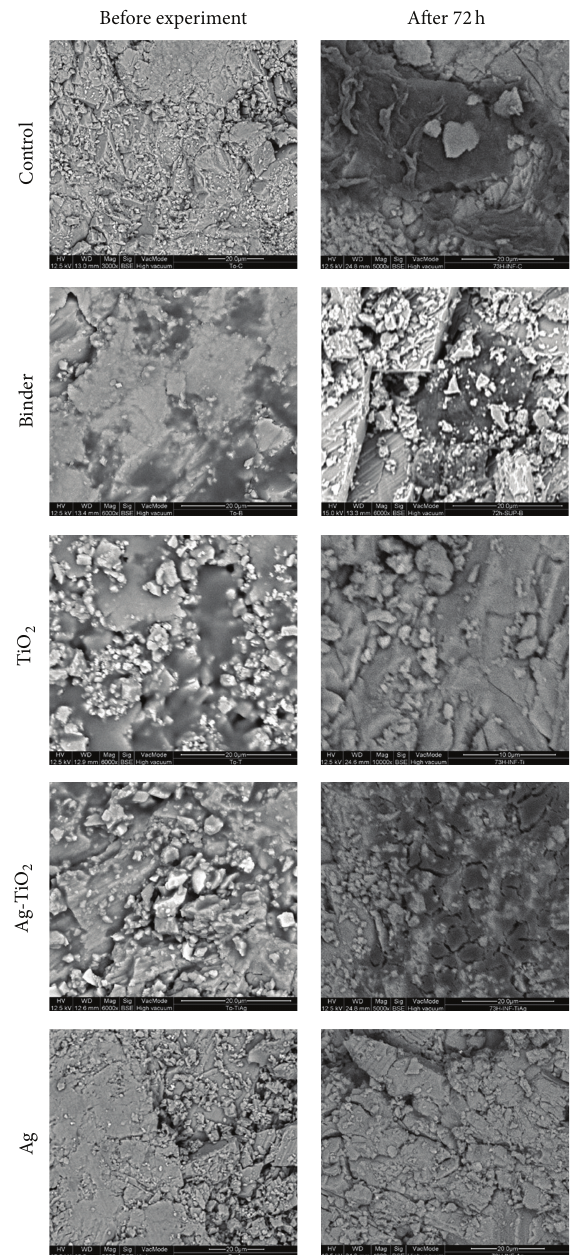
Figure 6: SEM pictures of the untreated and treated marble slabs before and after 72 hours of immersion in sea water